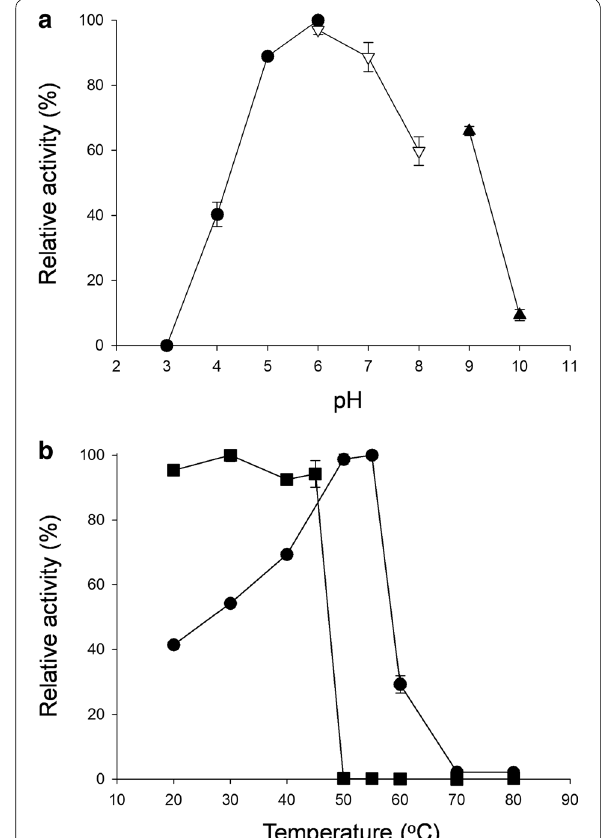
Fig. 3 Effects of pH and temperature on rAgaB‑4 activity. a Effects of pH on rAgaB‑4 activity. The buffer solutions used for different